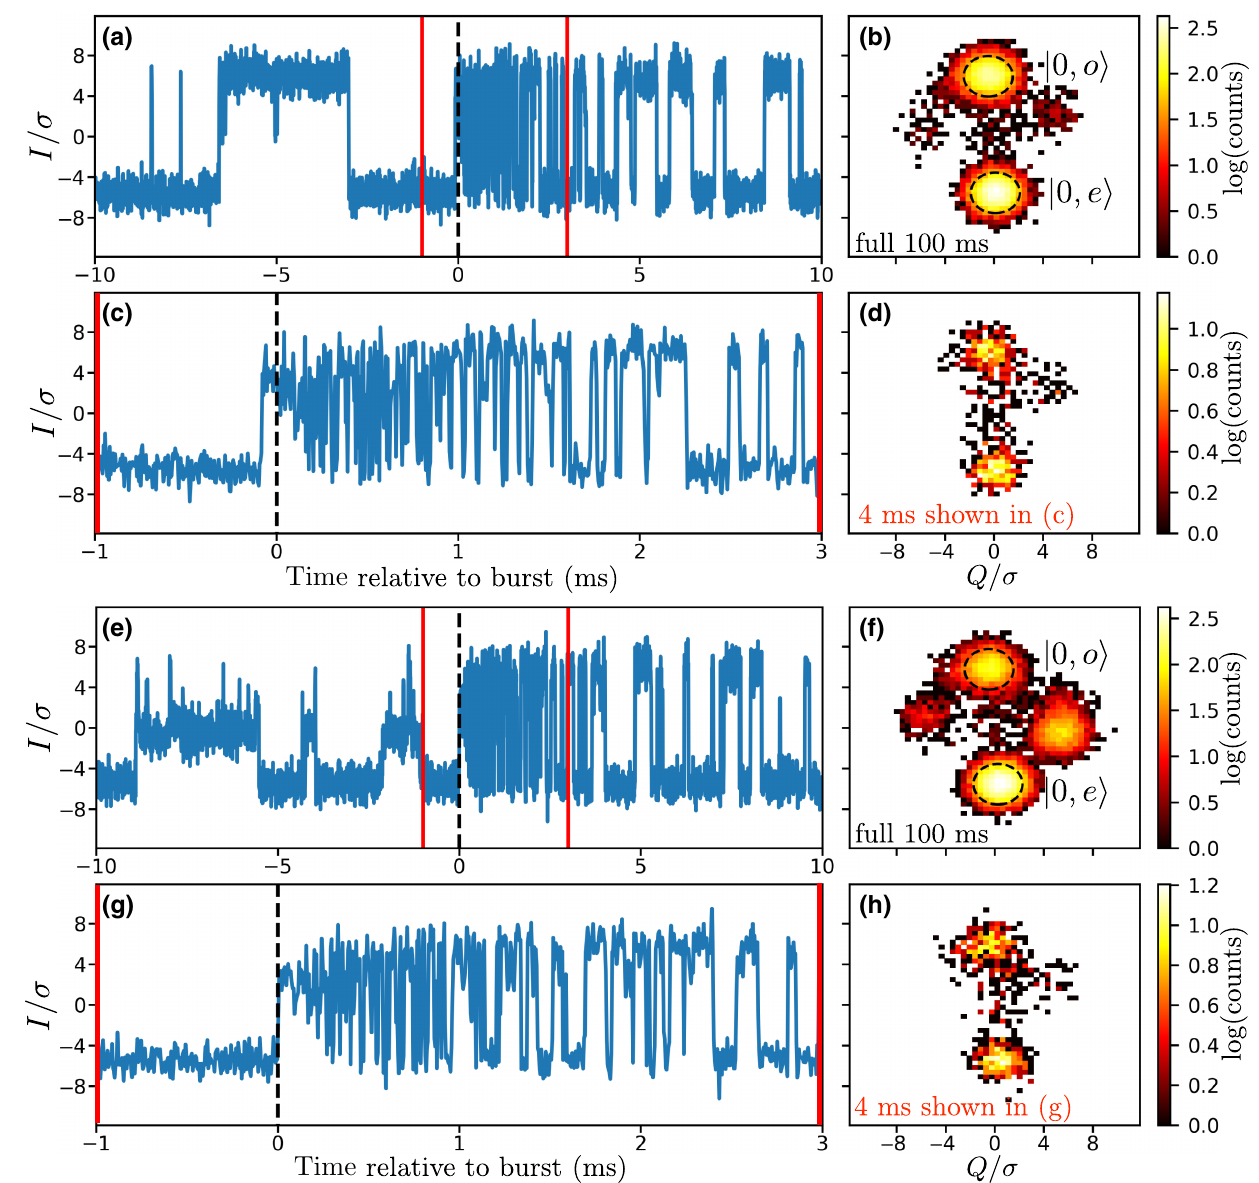
FIG. 15. (a) The time series of the I quadrature of qubit-state measurements repeated every 5 μ s, in units of the σ of the Gaussian distributions of the ground-state measurement histograms. Rapid switching between parity states begins at t = 0, which we attribute to a “burst” of QPs generated by ionizing radiation. (b) The 2D histogram of qubit-state measurements in the complex plane for the full 100-s time series from which the data in (a) are drawn, shown for state identification. Most of the counts form two Gaussian distributions with positive Q , which we attribute to the even- and odd-parity ground states, respectively. The counts at negative Q correspond to excited states of the qubit. The data are plotted in log scale for visibility of excited states and the dashed lines indicate 2 σ . (c) An enlargement of (a), showing 4 ms around the onset of the burst. The value jumps to a value between | 0, e (cid:5) and | 0, o (cid:5) due to switching that is fast compared to the 1 /( 5 μ s ) measurement repetition rate. This is followed by rapid switching between the parity states, which decays in frequency over time. (d) The same as (b), but for only the data in the window between the red lines shown in (c). The data are primarily in the ground states, showing that the data near I ≈ 0 at t = 0 are due to rapid switching rather than a jump to an excited state. Panels (e) and (f) are analogous to (a)–(d), but show a burst correlated with a jump in n g due to the redistribution of charge in the substrate resulting from the ionizing impact. At t < 0, the | 0, o (cid:5) state is located at I /σ ≈ 0, Q /σ ≈ 6 and parity switches occur between the even- and odd-parity ground states in this configuration. When the burst occurs at t = 0, the | 0, o (cid:5) state jumps to the same configuration as in (a)–(d), indicating a jump in n g correlated with a